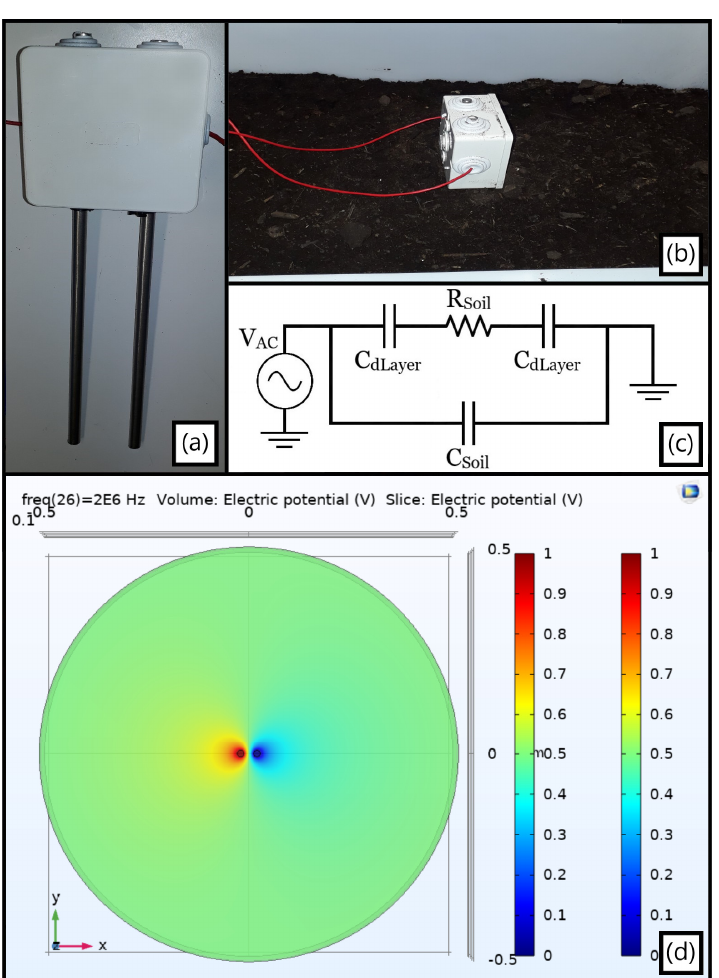
Figure 13. ( a ) Moisture probe with two parallel inox rods; ( b ) Vertically positioned device inside the plastic box soil; ( c ) Simplified electrical equivalent circuit sensed by the equipment; ( d ) Three-di- mensional F.E.M. outcomes yielded at 2 MHz and viewed at the xy plane for the single metallic rods pair in a wide 50 cm-radius homogeneous terrain with no insulating perimeter.